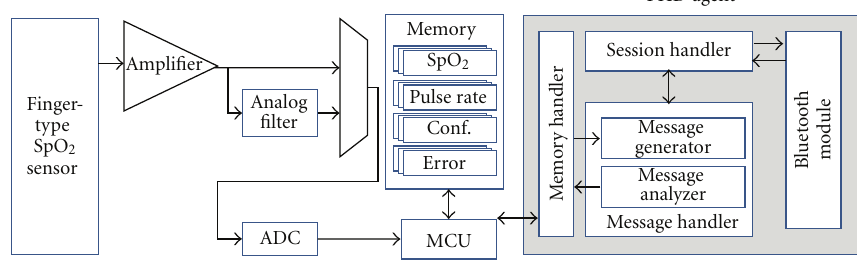
Figure 3: Architecture of the pulse oximeter.